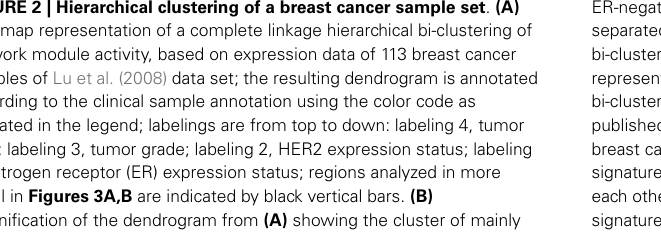
ER-negative, mainly HER2-negative, high grade ductal samples that is separated from all other samples. (C) Cluster dendrogram resulting from bi-clustering based on expression values of all individual genes represented in the network. (D–G) Cluster dendrograms resulting from bi-clustering of the breast cancer samples based on expression values of published discriminative gene signature sets generated specifically for breast cancer samples (D) Wang et al. (2005) (E) van’tVeer et al. (2002) a signature generated more generally to distinguish cancer samples from each other (F) Rhodes et al. (2004) and another breast cancer specific signature from Paik et al. (2004) (G)